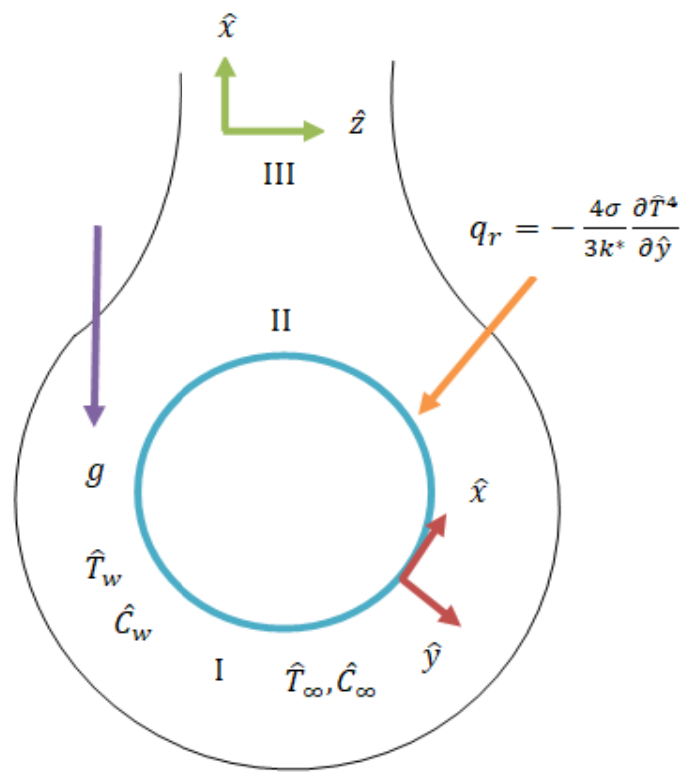
Figure 1. Coordinate system and flow configuration.